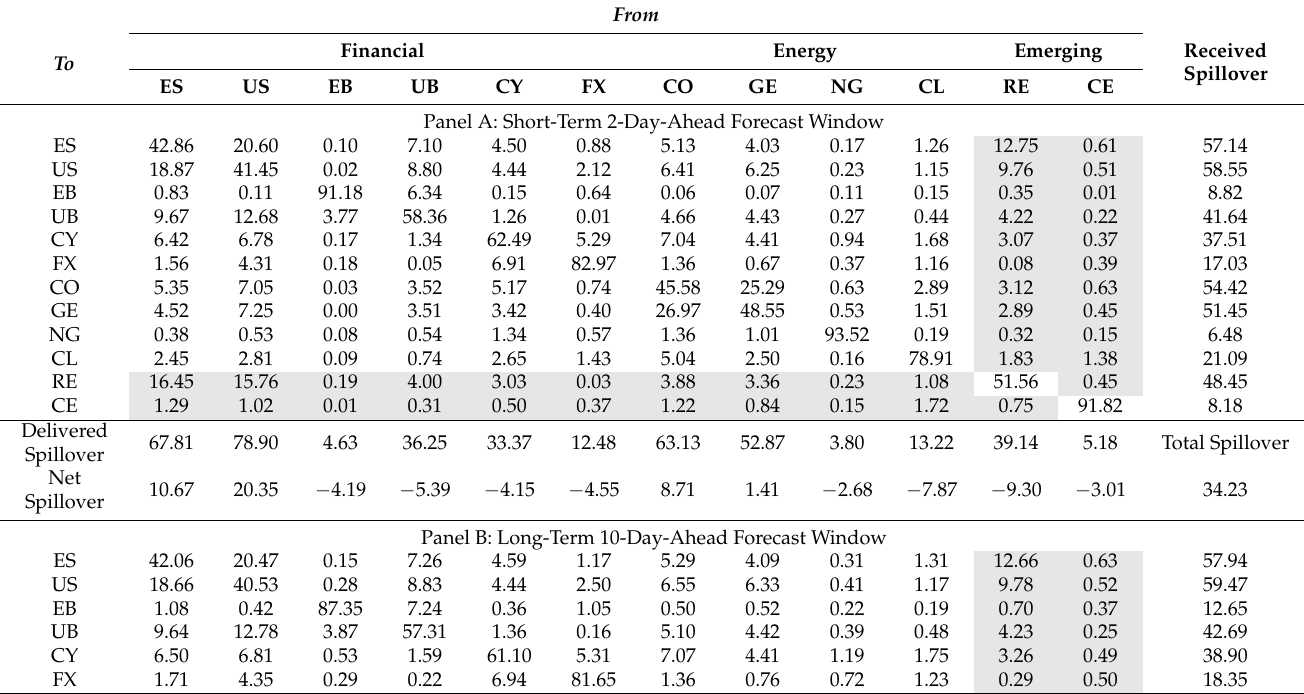
Table A2. Whole Period Return Spillover Indexes of Markets in the “Carbon–Renewable Energy–Finance–Energy” Market System based on Different Forecast